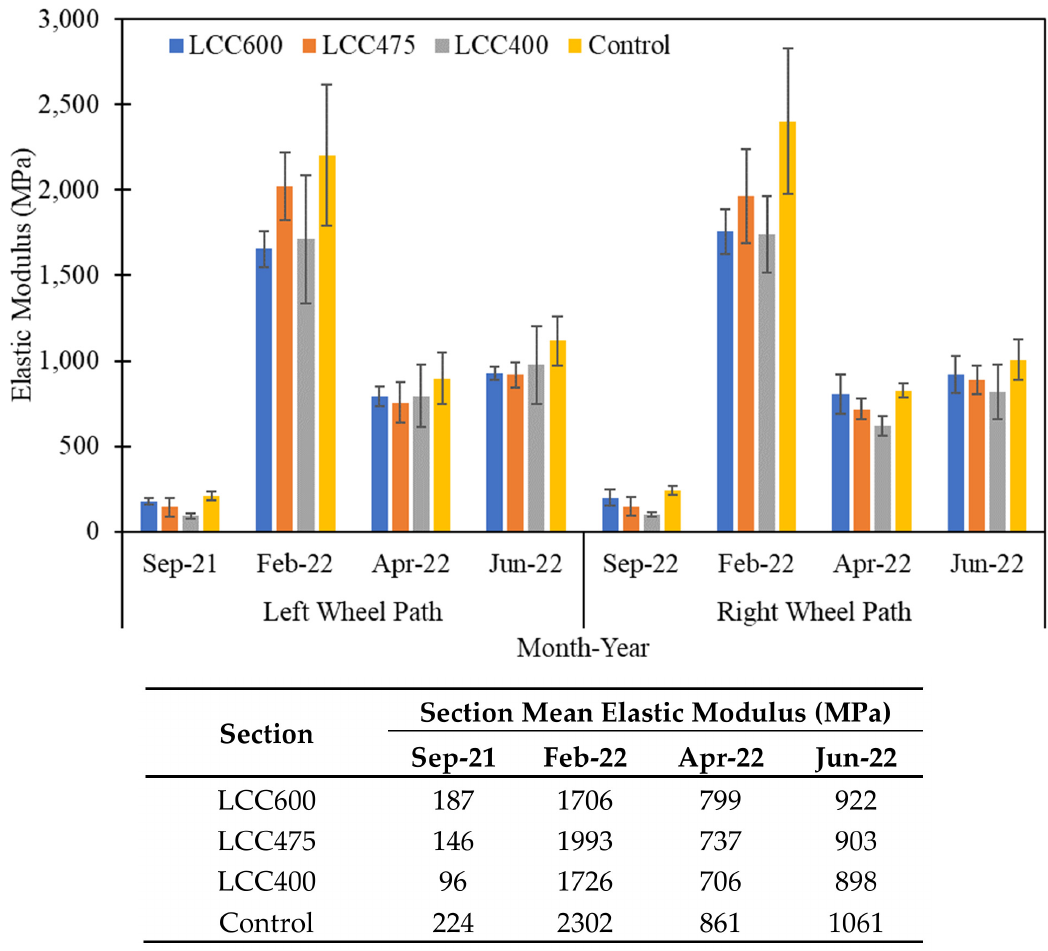
Figure 8. Notre Dame Drive southbound measured elastic modulus.